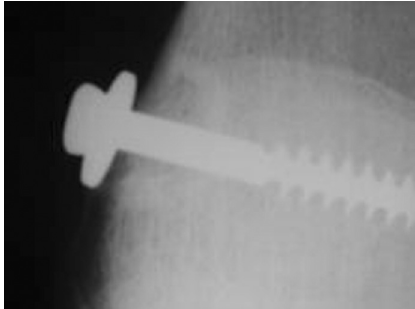
Figure 5 - Image of the screw in the bone one year after